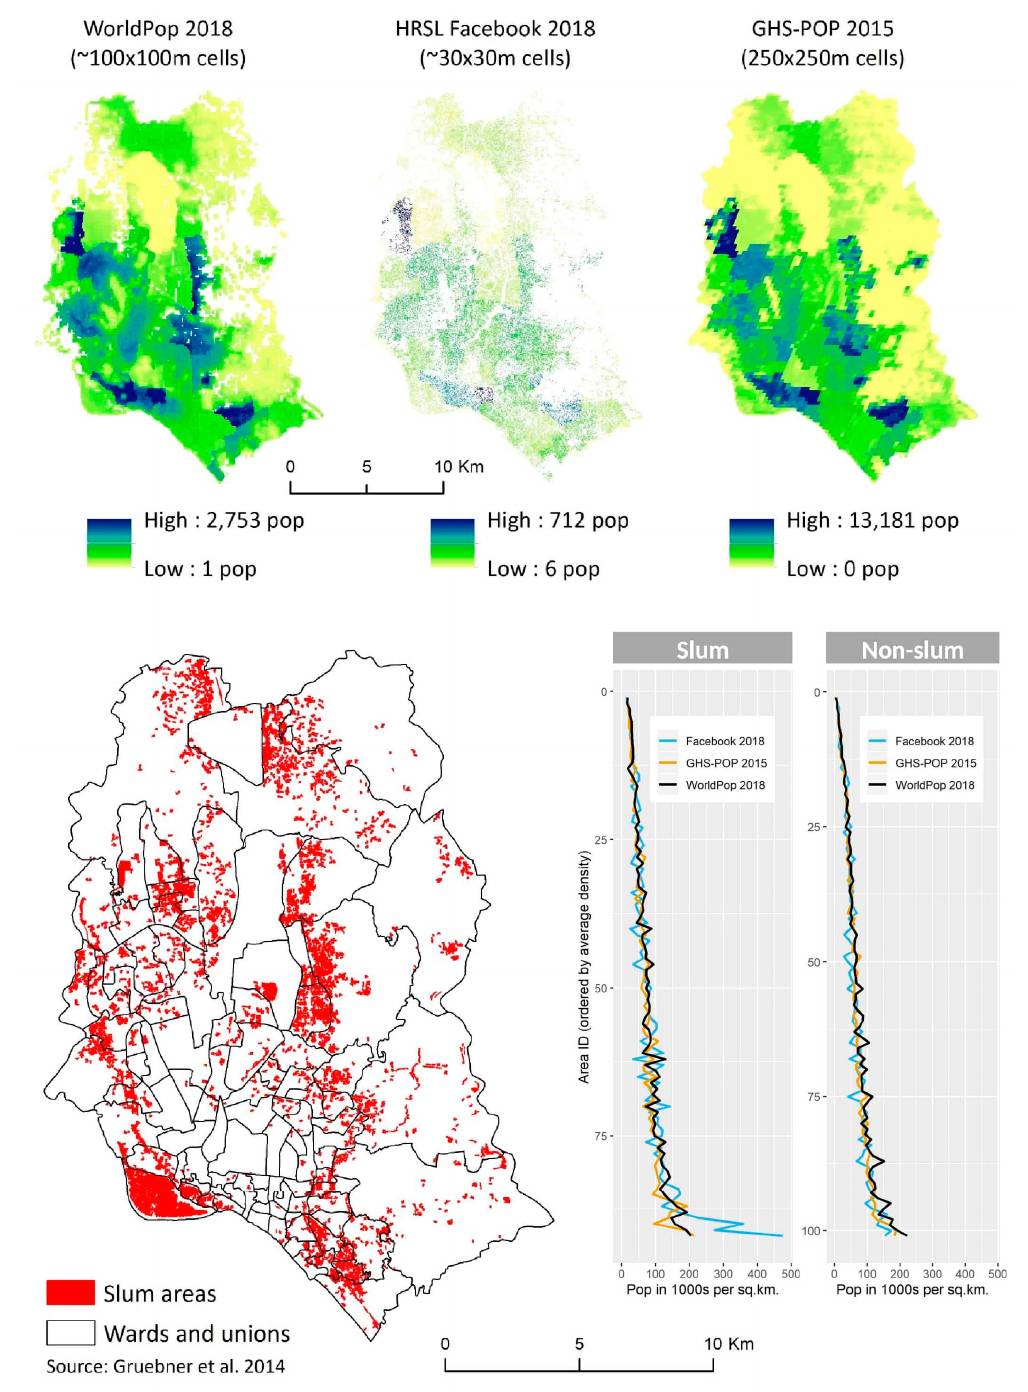
Figure 3. Three gridded population estimates and “slum” area boundaries in Dhaka, Bangladesh with “slum” and non-“slum” area population density